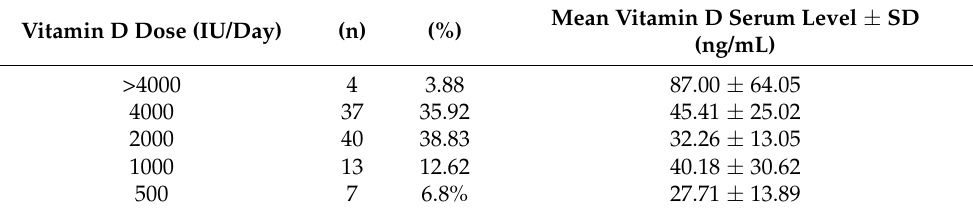
Table 3. Vitamin D serum levels among MS patients according to vitamin D supplementation daily dose.